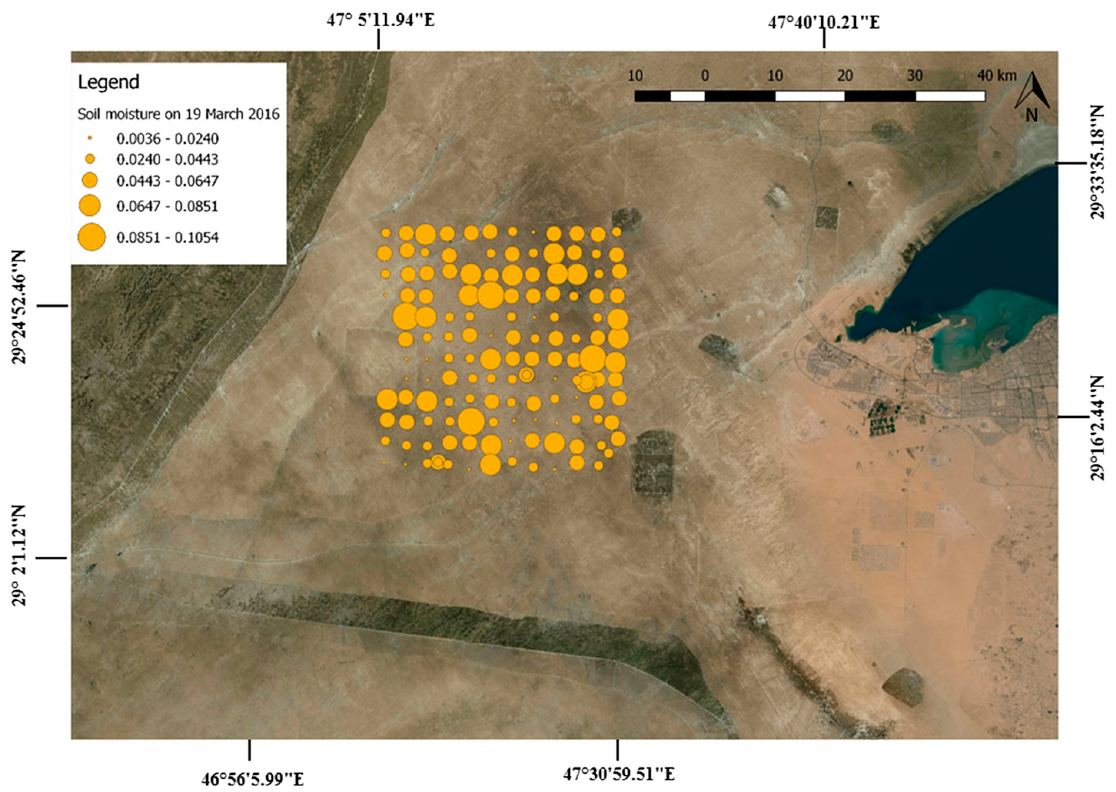
Figure 5. Spatial distribution of the measured VSM on 19 March 2016.